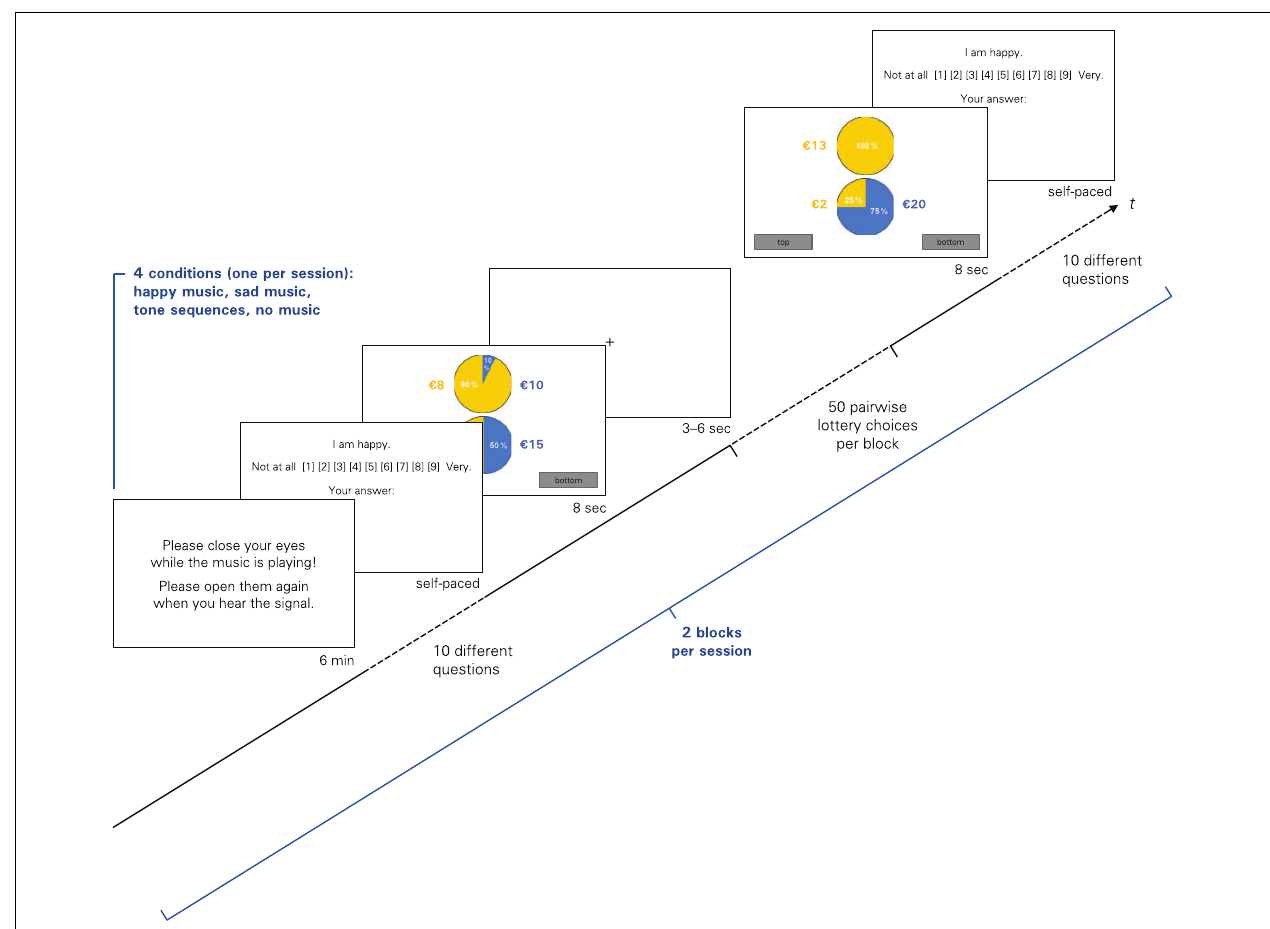
FIGURE 1 | The sequence of events forming one block in the experiment. Each condition consisted of two such blocks, separated by a short break.